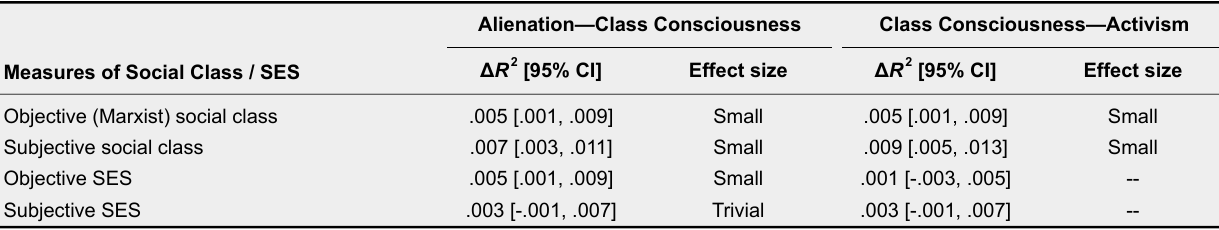
Class Consciousness—ActivismAlienation—Class Consciousness